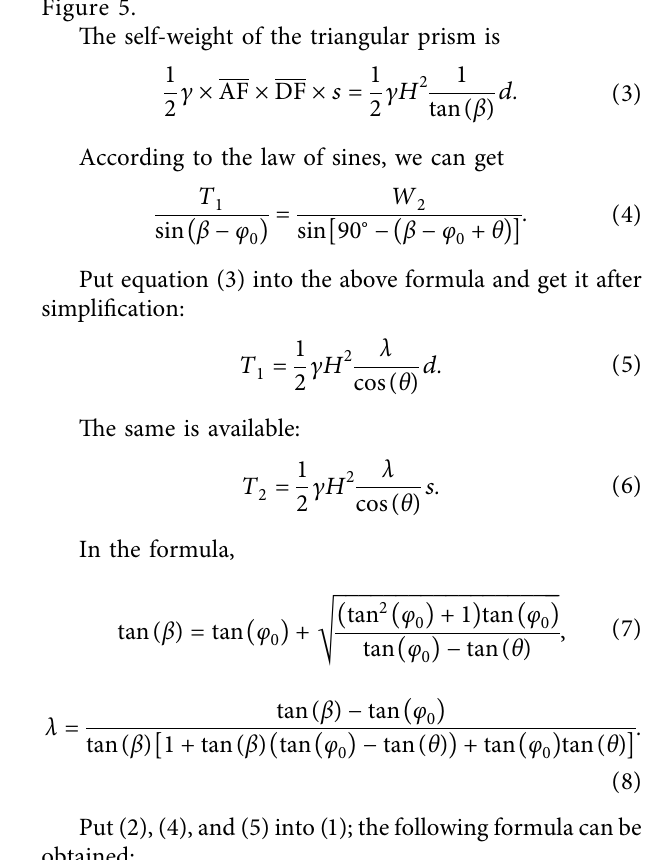
Figure 1: Potential failure shape of the tunnel face.